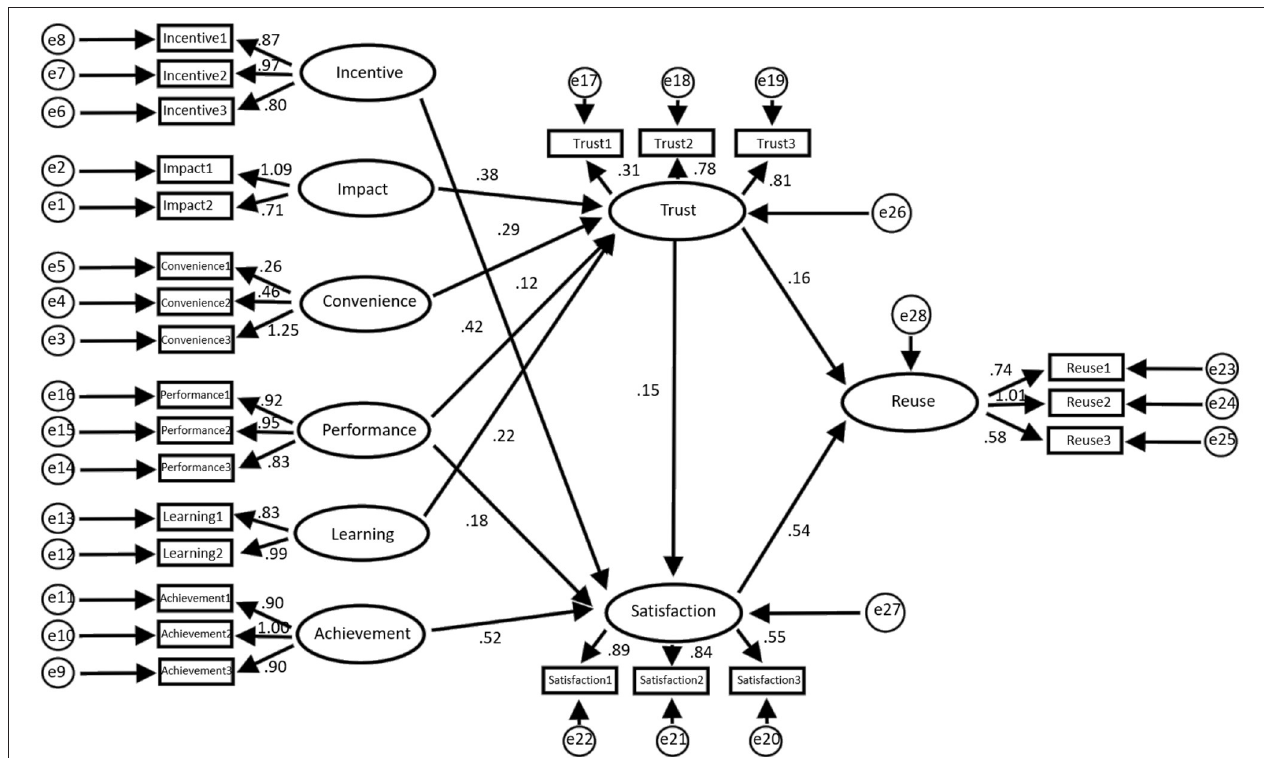
FIGURE 8 | Administrator